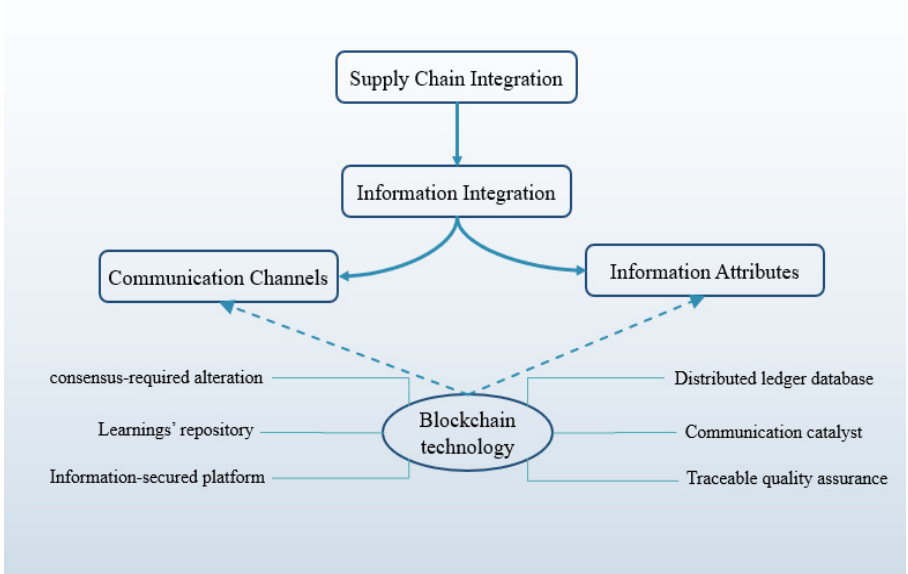
Figure 1. Knowledge gap design.